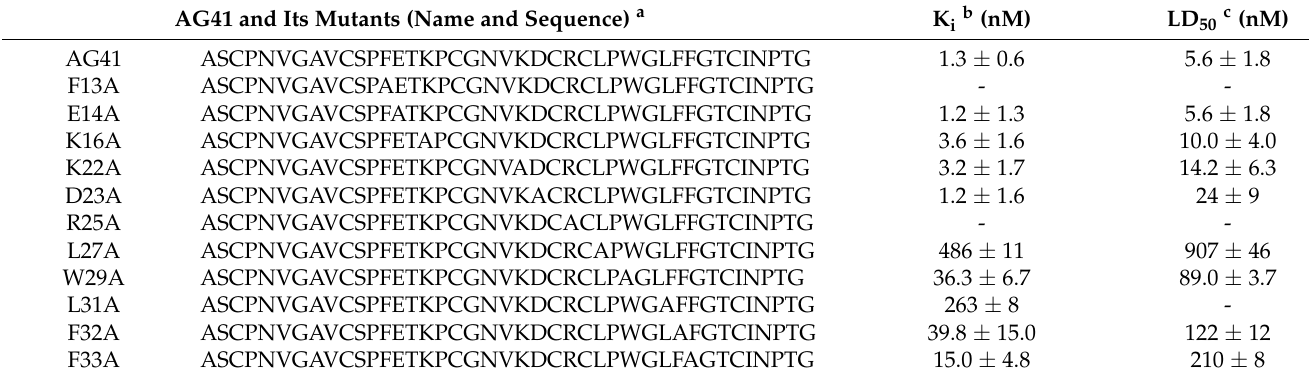
Table 2. Affinity to the PA1b receptor and insect cell toxicity of AG41 and its mutants. Values are provided as mean ± standard